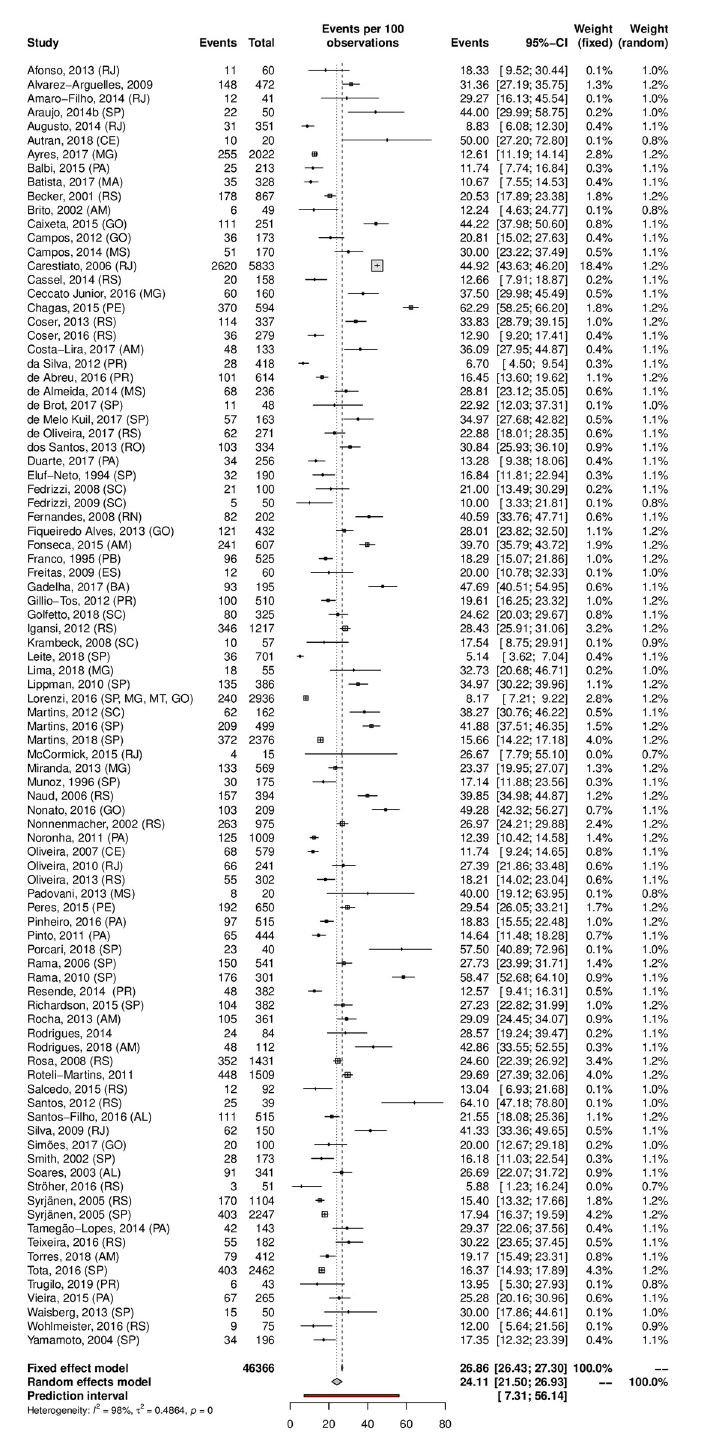
PLOS ONE | https://doi.org/10.1371/journal.pone.0229154 February 21,